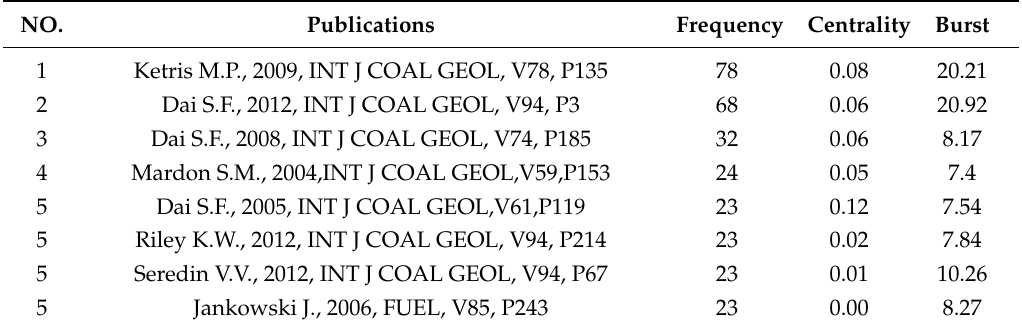
Table 7. Characteristics of highly cited publications of trace elements in coal and ash during 1999–2017. NO.